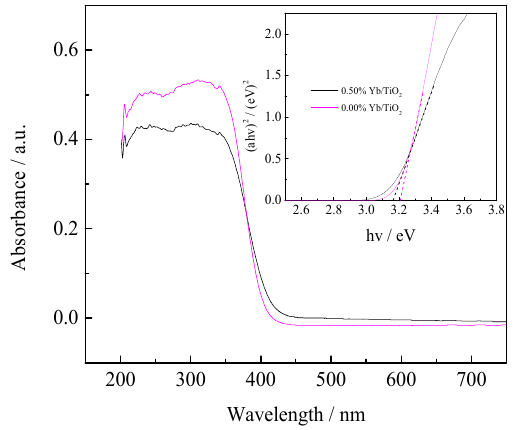
Figure 3. UV-Vis DRS spectra of pure TiO 2 and 0.50% Yb/TiO 2 . UV-Vis DRS: UV-visible